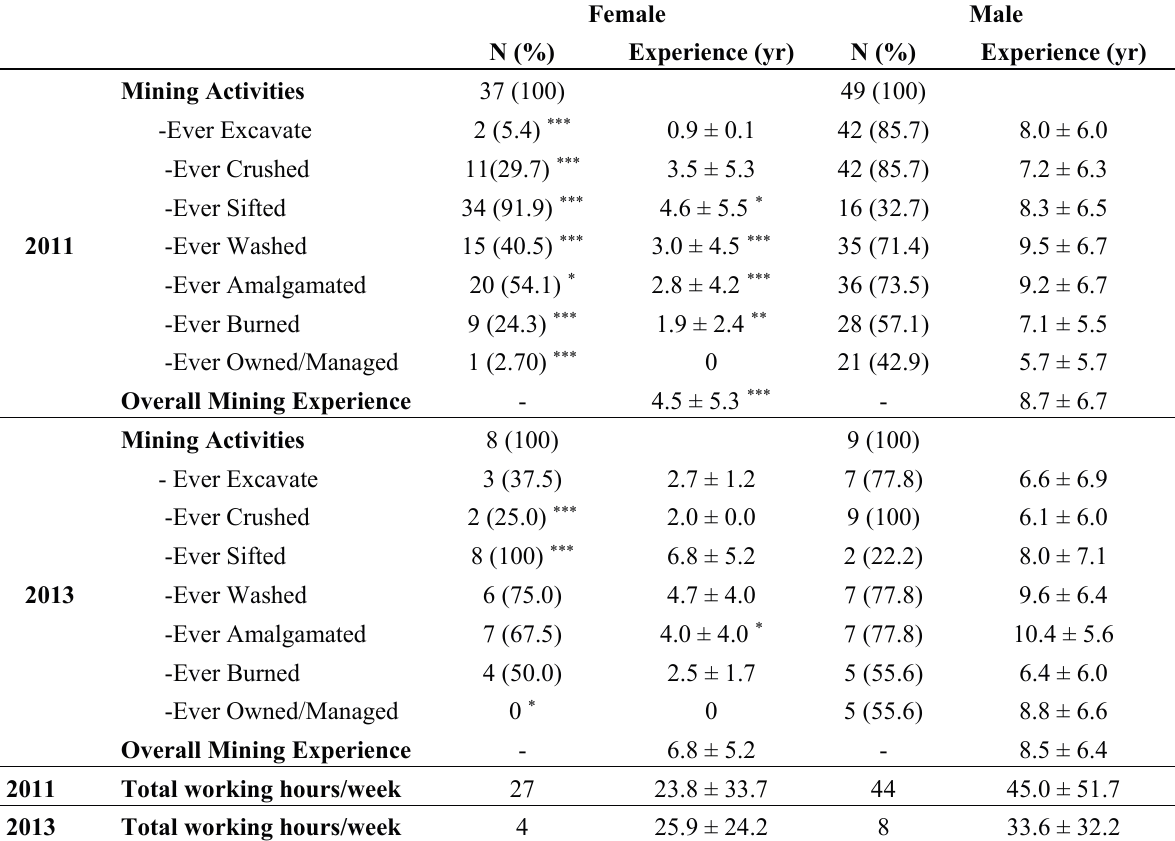
Table S1. Comparison of mining experience between male and female ever-miners in 2011, 2013. Female Male N (%) Experience (yr) N